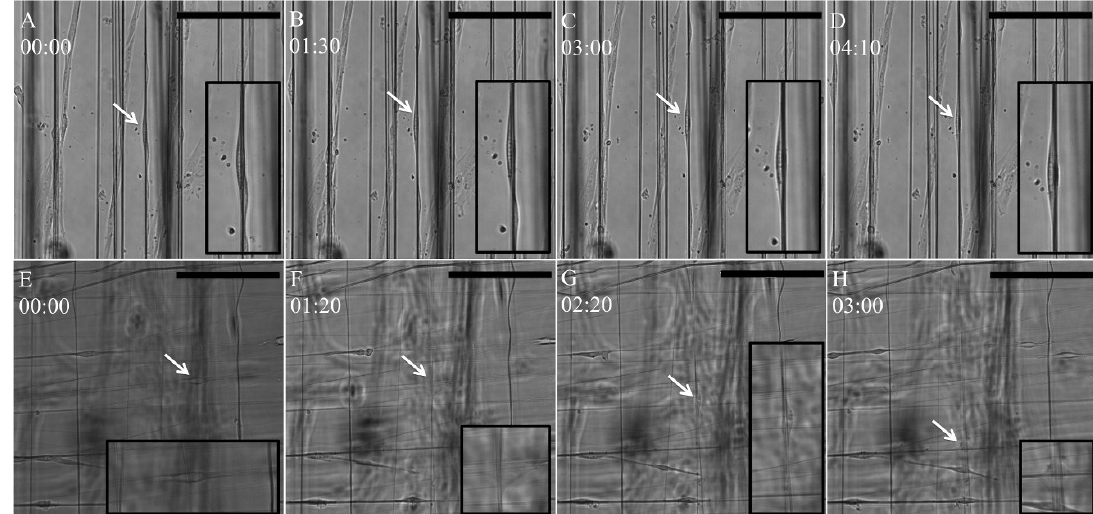
Figure 3. Time-lapse frames of MSCs on aligned fibers. Representative time-lapse microscopy images of equine bone marrow MSCs on aligned parallel fibrous scaffolds ( A – D ) and aligned perpendicular scaffolds ( E – H ) over 12 h. Time (hours) is indicated in the upper left corner. Arrows tack cell migration during the time-lapse. Insets show enlarged image of the cell. Scale bar 200 μ m.